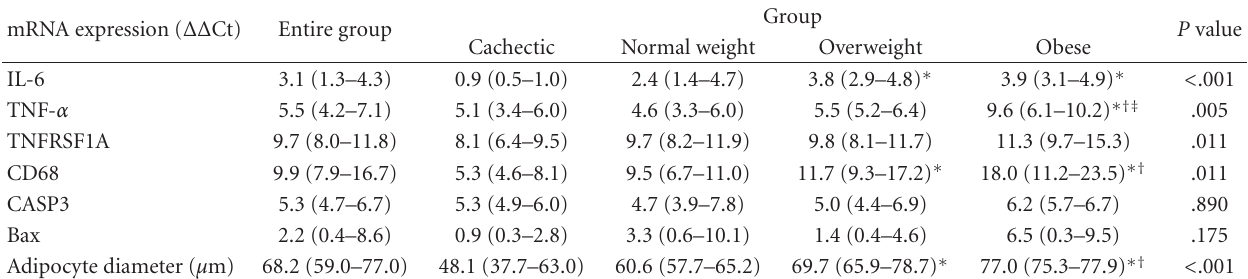
Table 4: Adipose tissue-relative expressions of interleukin 6, tumor necrosis factor-alpha and its receptor, CD68, CASP3, and Bax gene in patients with COPD.